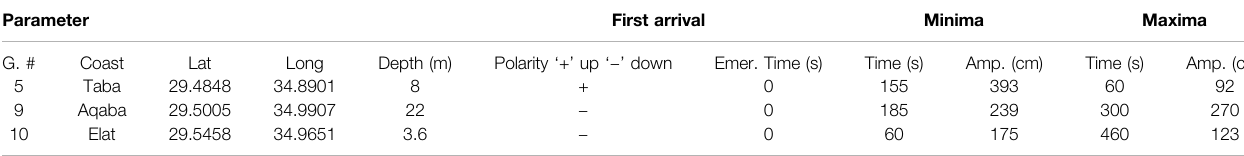
TABLE 3 | Waveform characteristics of Elat fault scenario recorded by the three arti fi cial tide gauges located in the head of the Gulf of Elat – Aqaba (HGEA). Parameter First